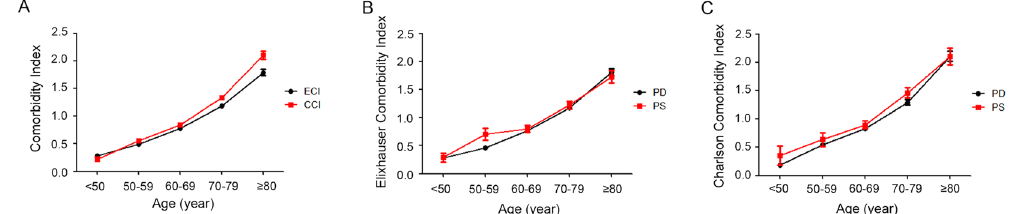
Figure 1. Associations of the comorbidity burden with age. All subjects were divided into 5 sub-groups ( < 50 years, 50–59 years, 60–69 years, 70–79 years and ≥ 80 years) by age. The comorbidity indices, including the